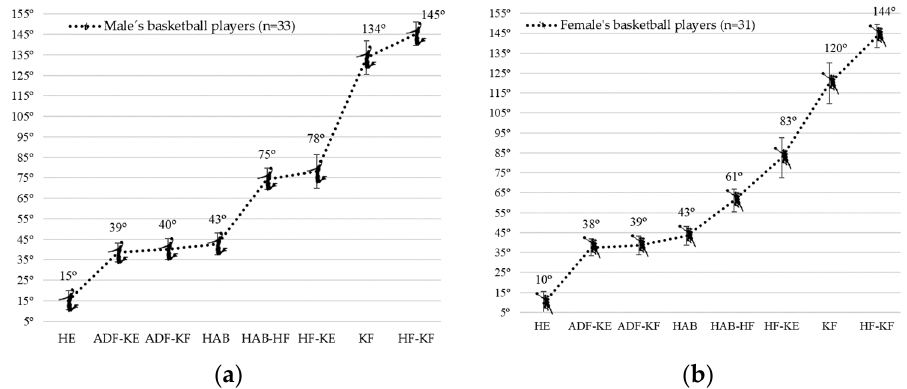
Figure 1. ( a ) Lower extremity flexibility profile for the 33 male basketball players; ( b ) Lower extremity flexibility profile for the 31 female basketball players (mean values of each range of motion test).